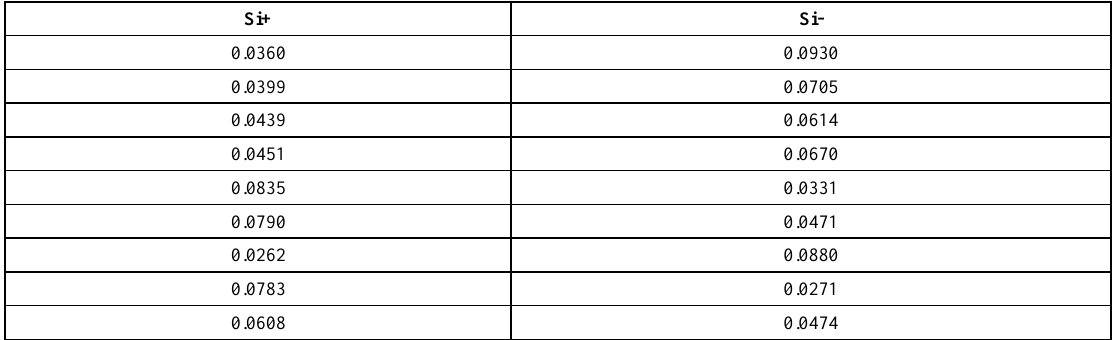
Table 7. Relative closeness (RC) of an alternative to the ideal solution& ranking of clusters